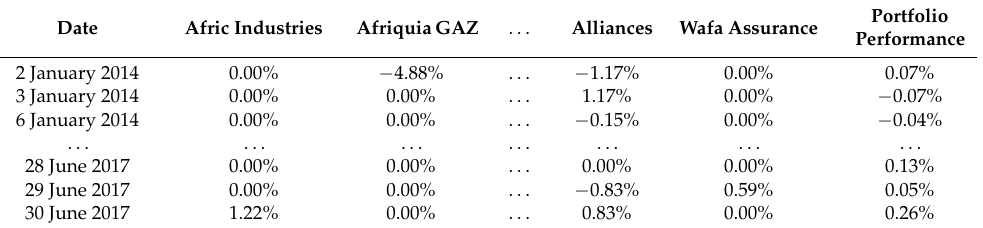
Table produced on Excel using VBA by the authors.